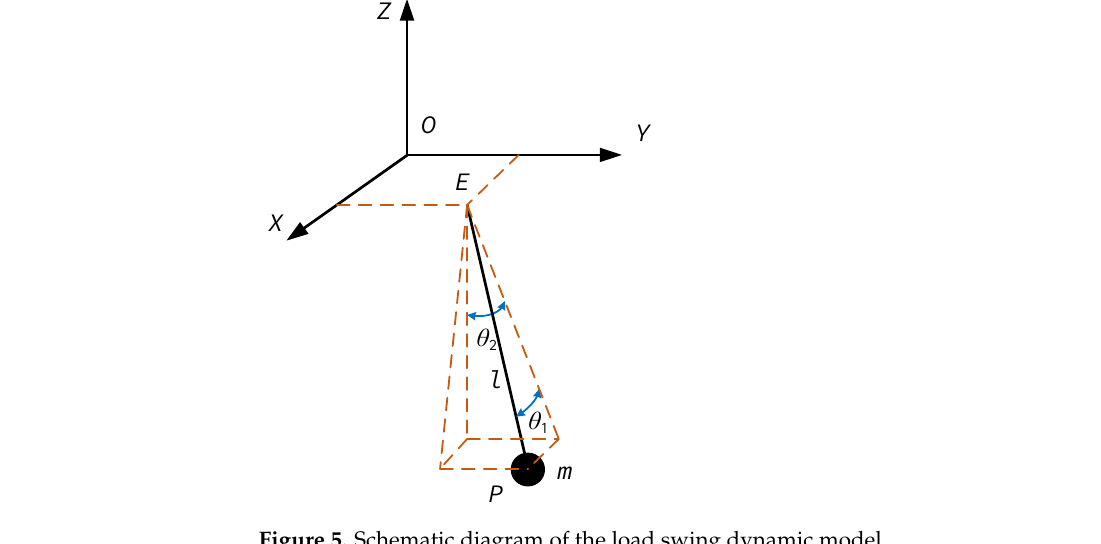
Figure 5. Schematic diagram of the load swing dynamic model.